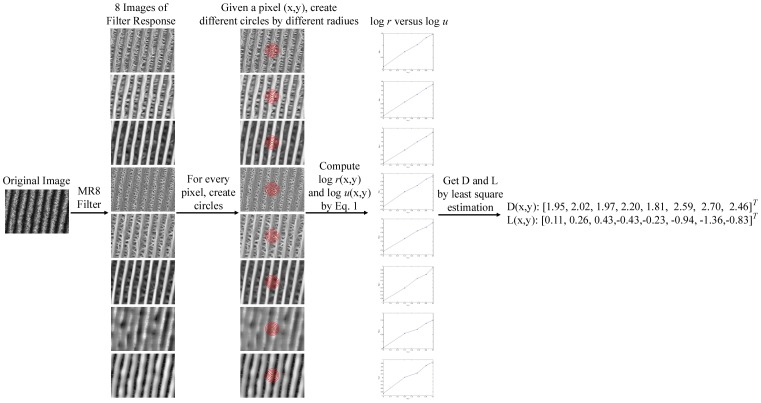
Illustration of computation for Statistical_Fractal [20].